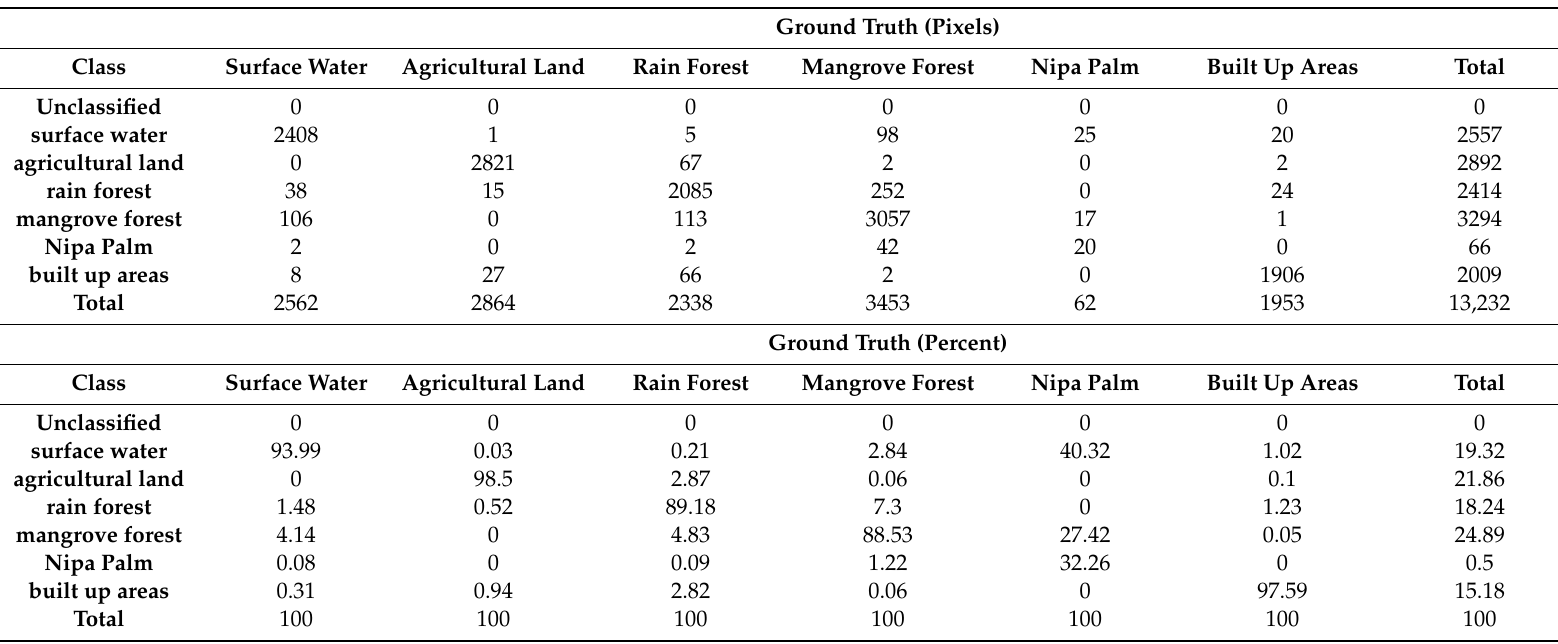
Table 4. Confusion Matrix of the 2017 SVM Radial Basis Function kernel Land Cover Classification of the Niger